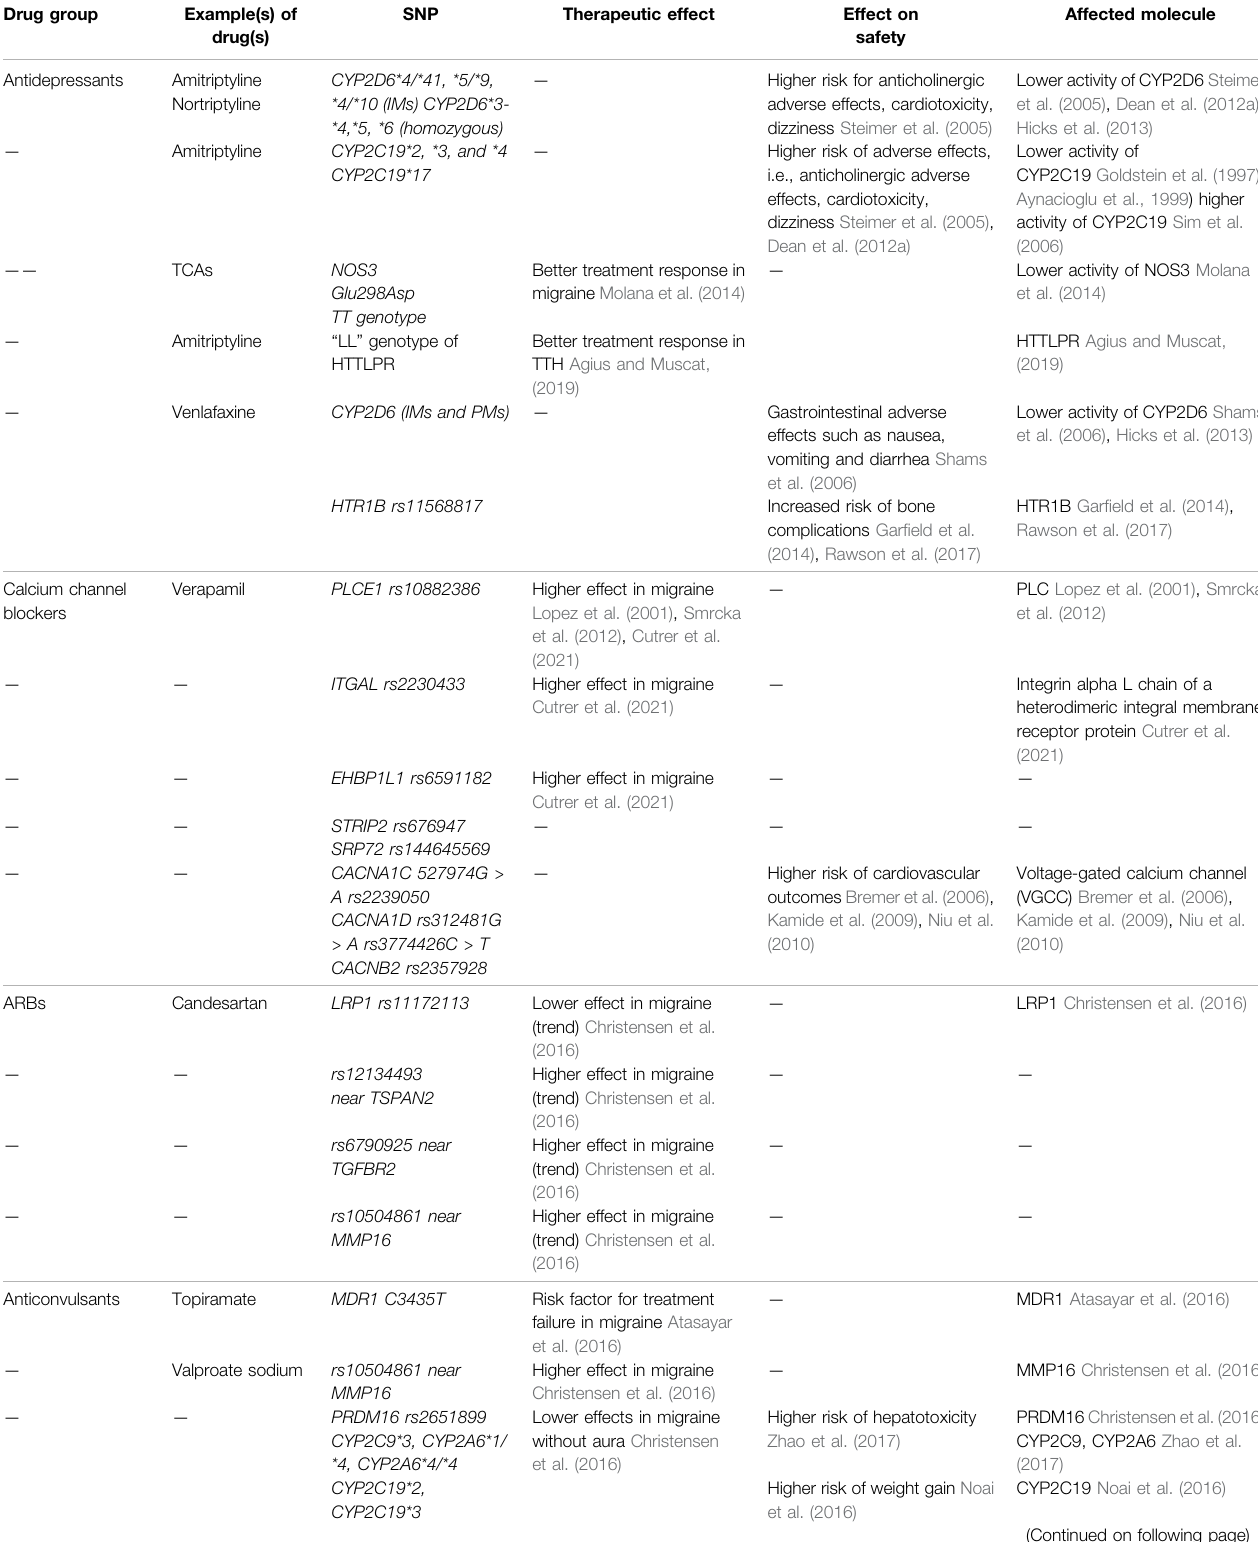
TABLE 4 | Important pharmacokinetic markers in preventive treatment of primary